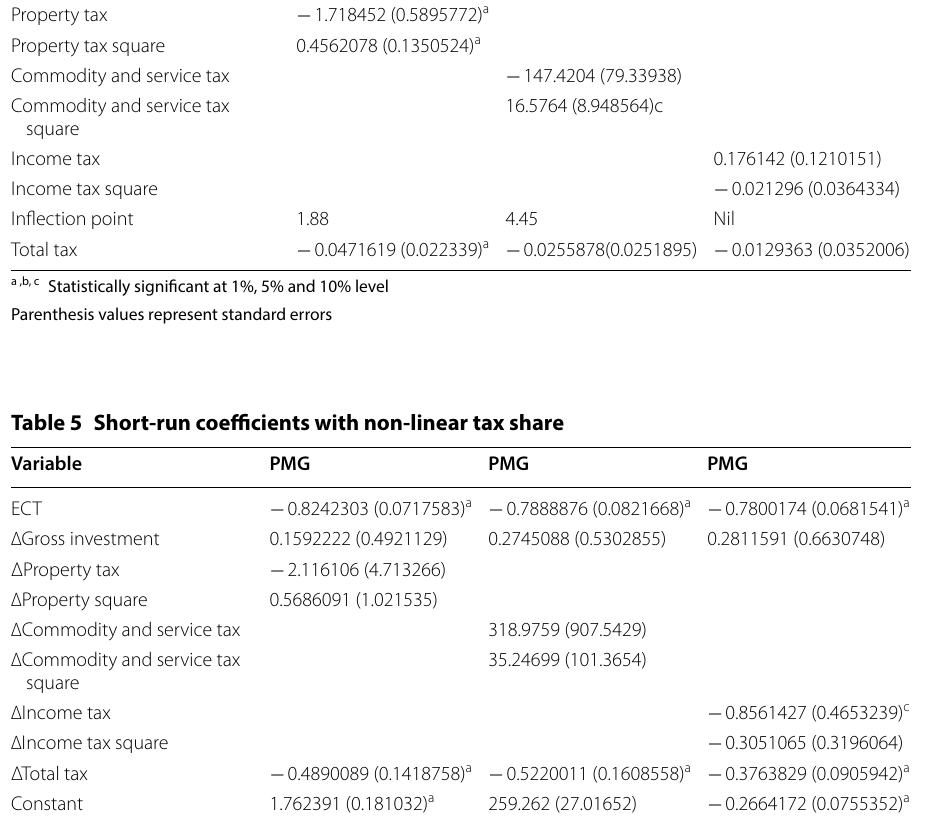
a, b, c Statistically significant at 1%, 5% and 10% level. Parenthesis values represent standard errors